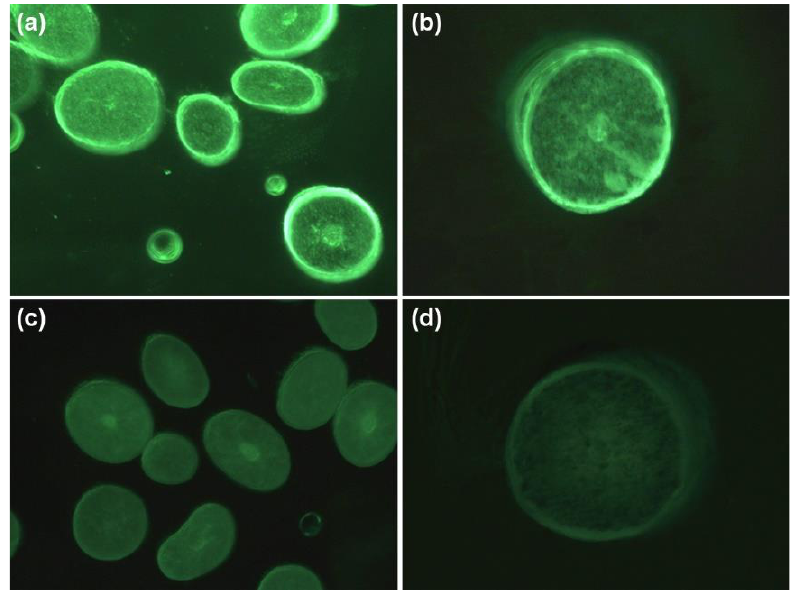
Figure 3. Cross sections of hair treated with fluorescent-labeled low-MW HA ( a , b ) and high-MW HA ( c , d ).